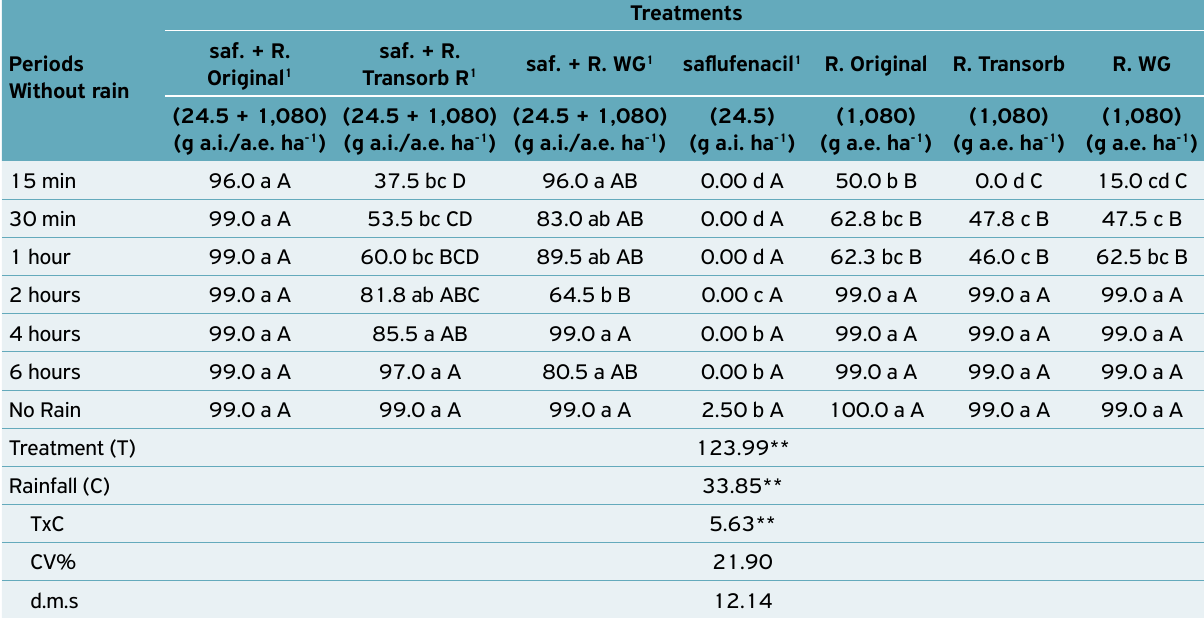
Means followed by the same lowercase letters in rows and uppercase in columns do not differ statistically by Tukey test (P < 0.05); 1 0.5% Dash added, DAA: Days After Application; R: Roundup; saf.: saflufenacil; **Significant at 1% probability